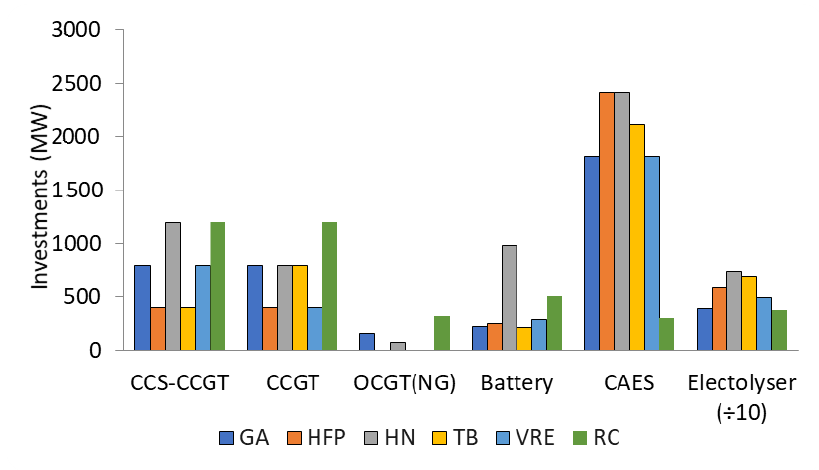
Figure 5. 2040 investments including dispatchable generation capacities and load (electrolysers).